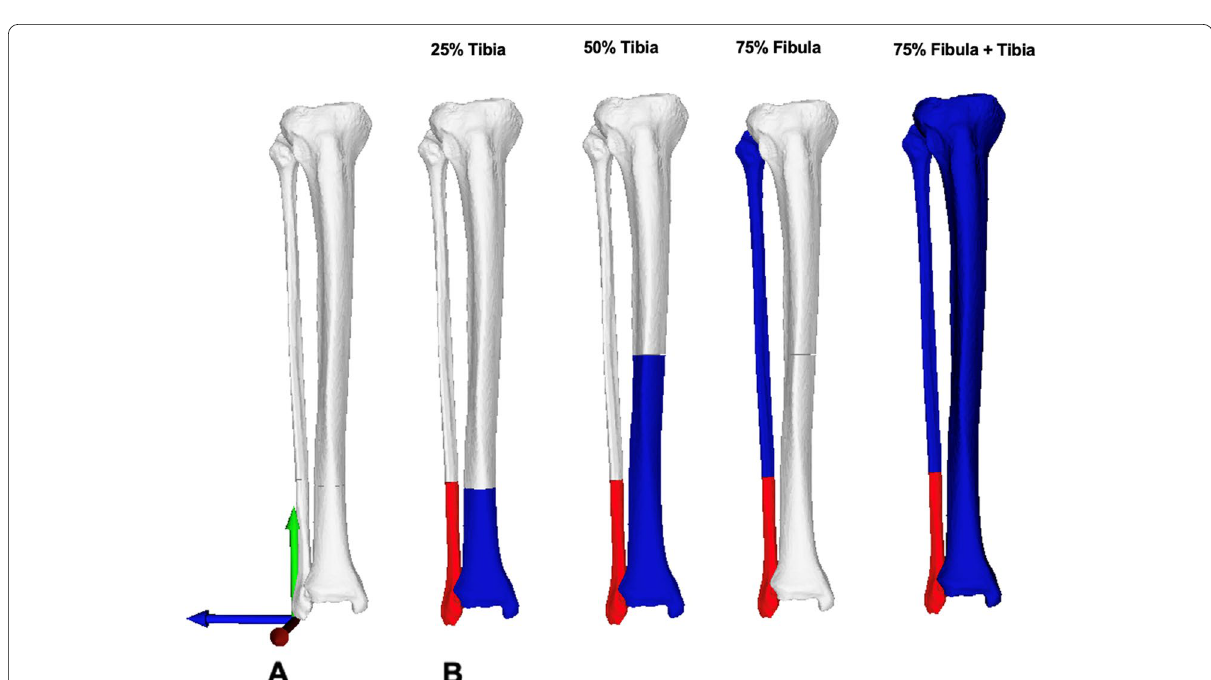
Fig. 2 Definition of tibia and fibula segments for contralateral registration. The contralateral model was mirrored and four anatomical segments were defined and depicted from left to right: 25% tibia: including 25% of the tibia length; 50% tibia: including 50% of the tibia length; 75% fibula: including 75% of the fibula length; 75% fibula and tibia: including 75% of the fibula length and the complete tibia